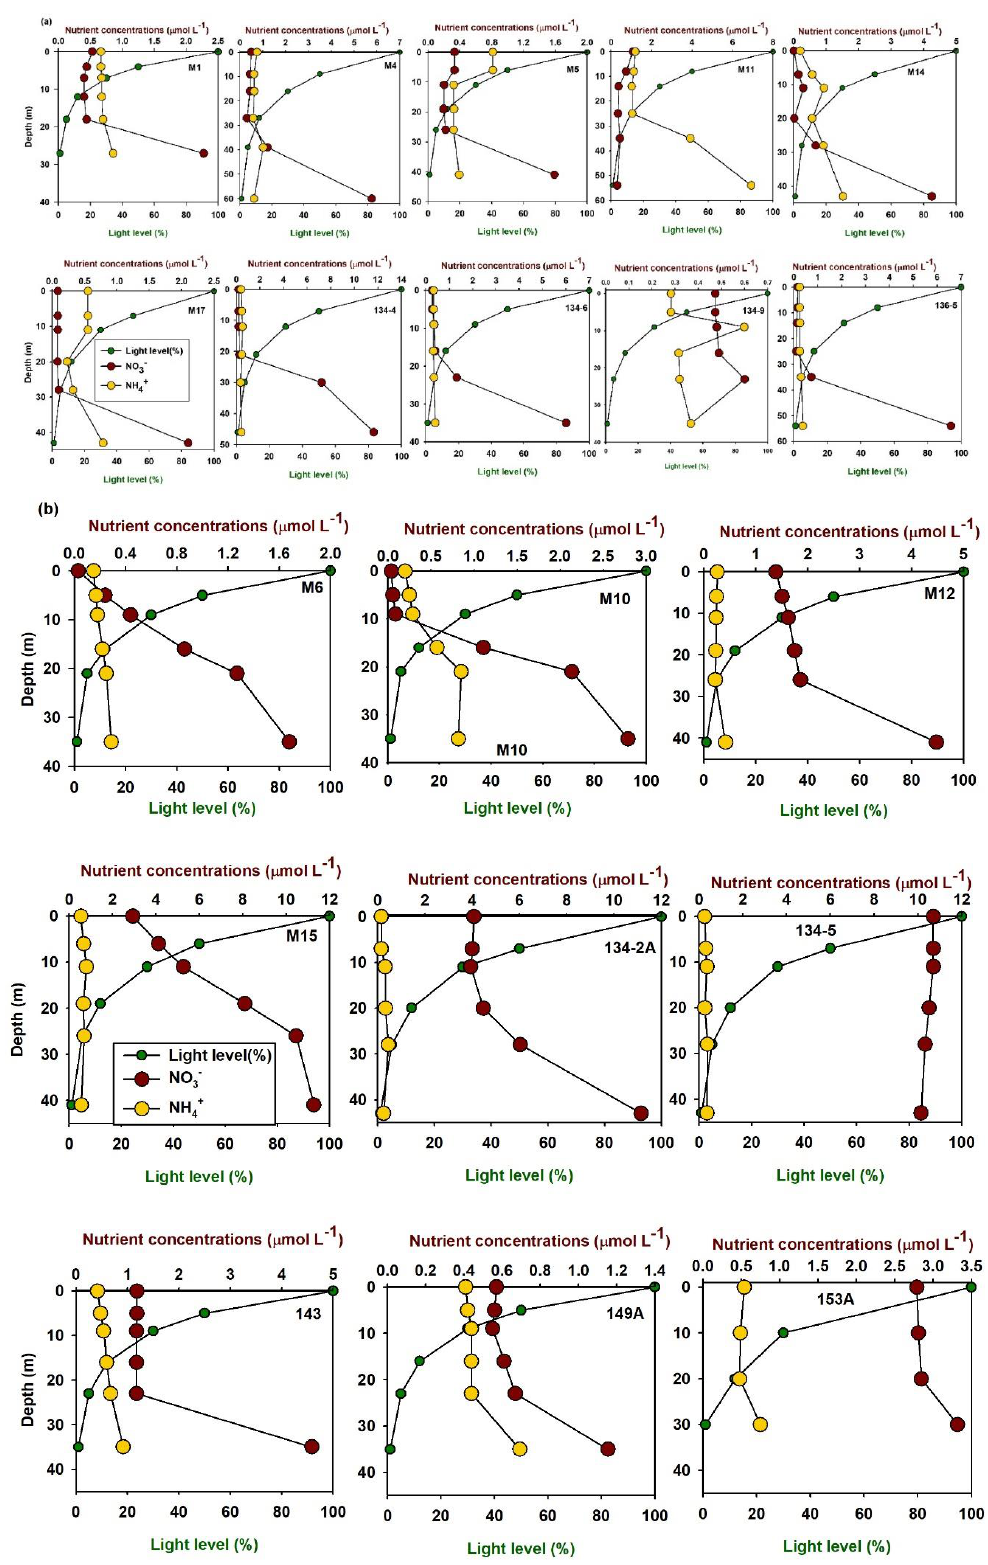
Figure 2. The depth profiles of the nutrient concentrations in the East / Japan Sea and the corresponding light levels for each station during 2012 ( a ) and 2015 ( b ). The station numbers are given on corresponding plots.